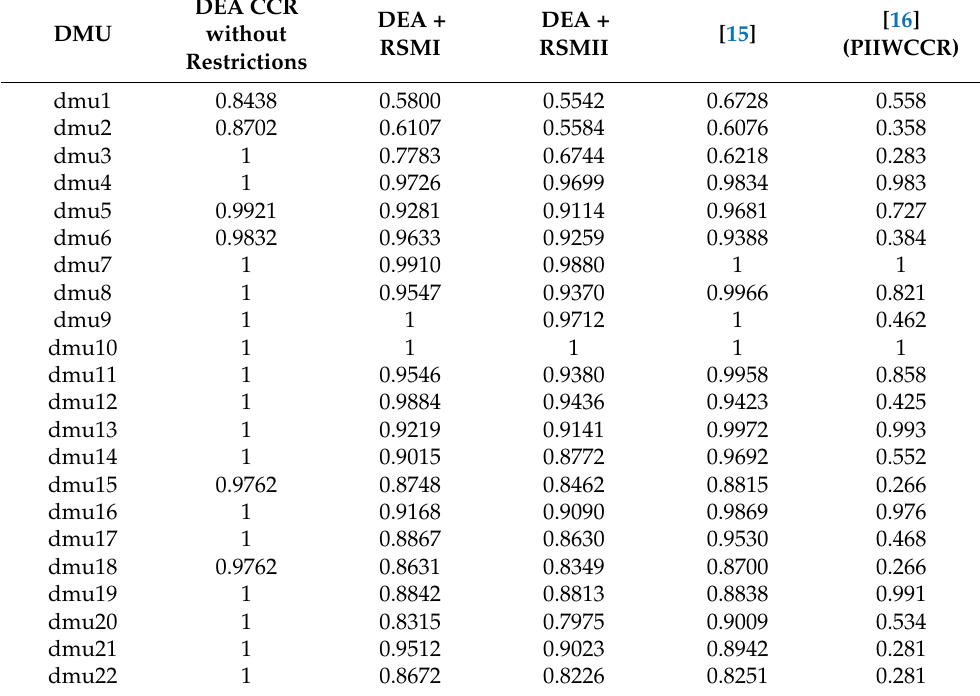
Table 12. Comparative of efficiency scores on DEA models on the example of [22] and our